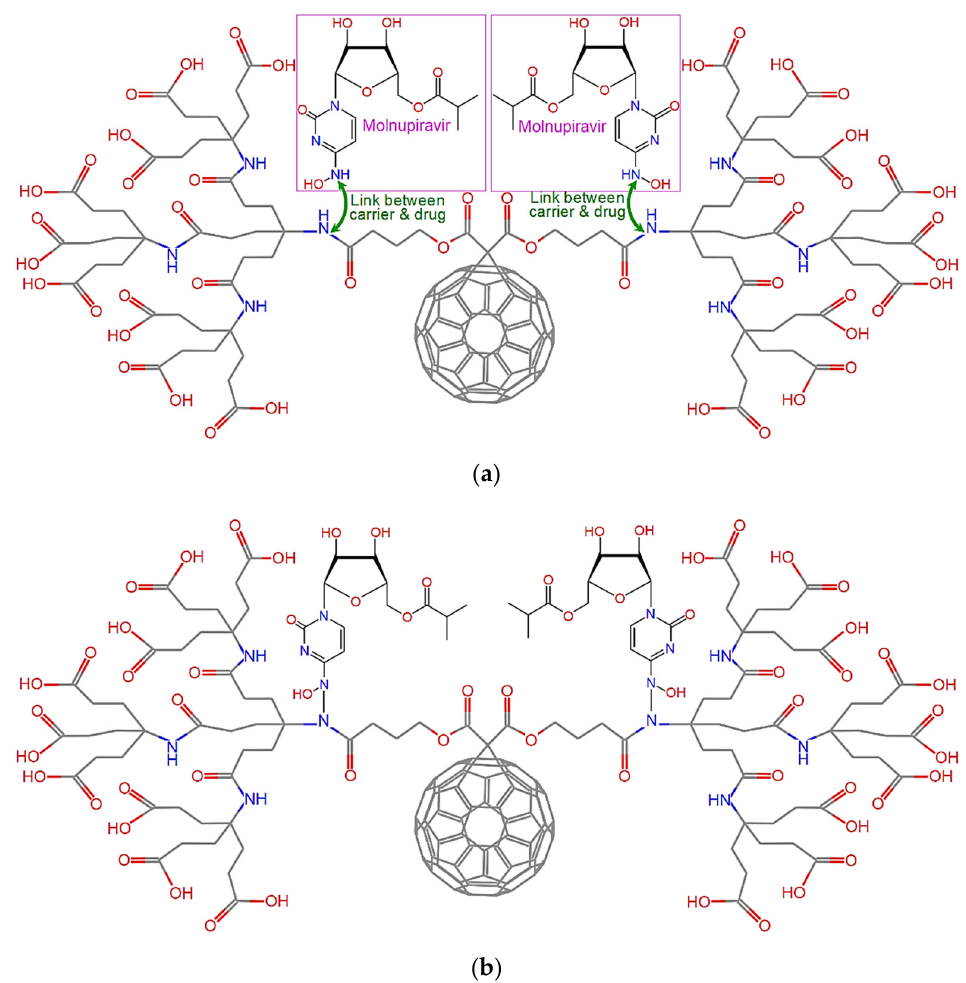
Figure 2. The proposed drug delivery system: ( a ) Locations of molnupiravir molecules input in dendro[60]fullerene and ( b ) final chemical structure.